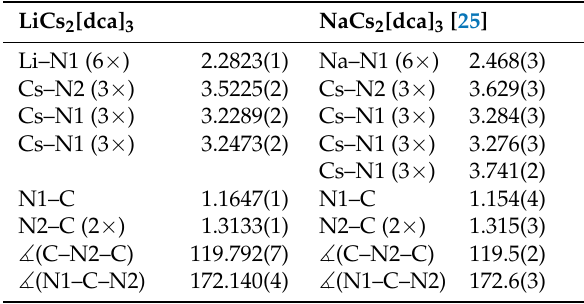
Figure 1 . Crystal structure of LiCs 2 [dca] 3 with ( a ) viewed along the c axis and ( b ) along the b axis. The thermal ellipsoids correspond to 90% probability using the refined ADPs. Table 1. Selected bond lengths (Å) and angles ( ◦ ) of LiCs 2 [dca] 3 in comparison to NaCs 2 [dca] 3 .